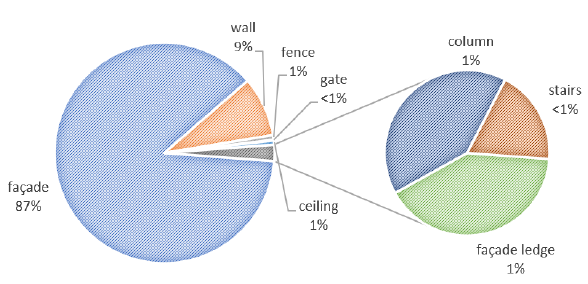
Figure 3. Ratio of annotated fac¸ade points per class and low fac¸ade classes variability, based on the example of the Oakland 3D point cloud